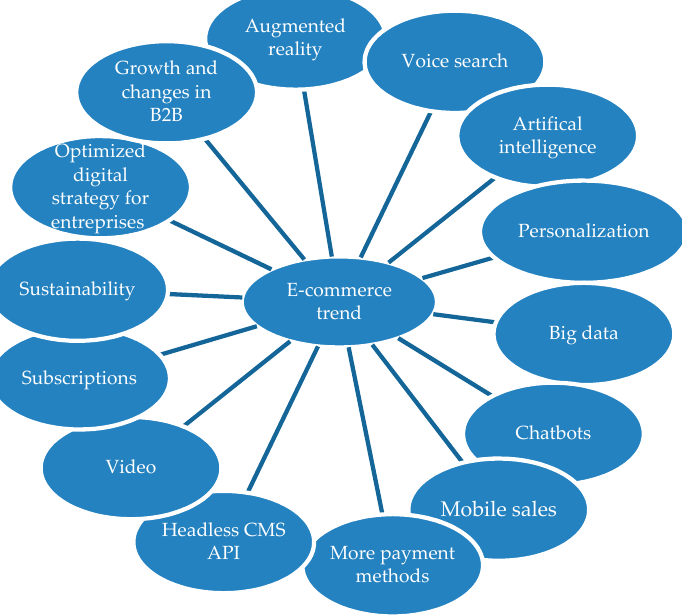
Figure 6. Trends in cross ‐ border e ‐ commerce. CMS— Content Management System; API—Application Programming Interface ; B2B—business ‐ to ‐ business.